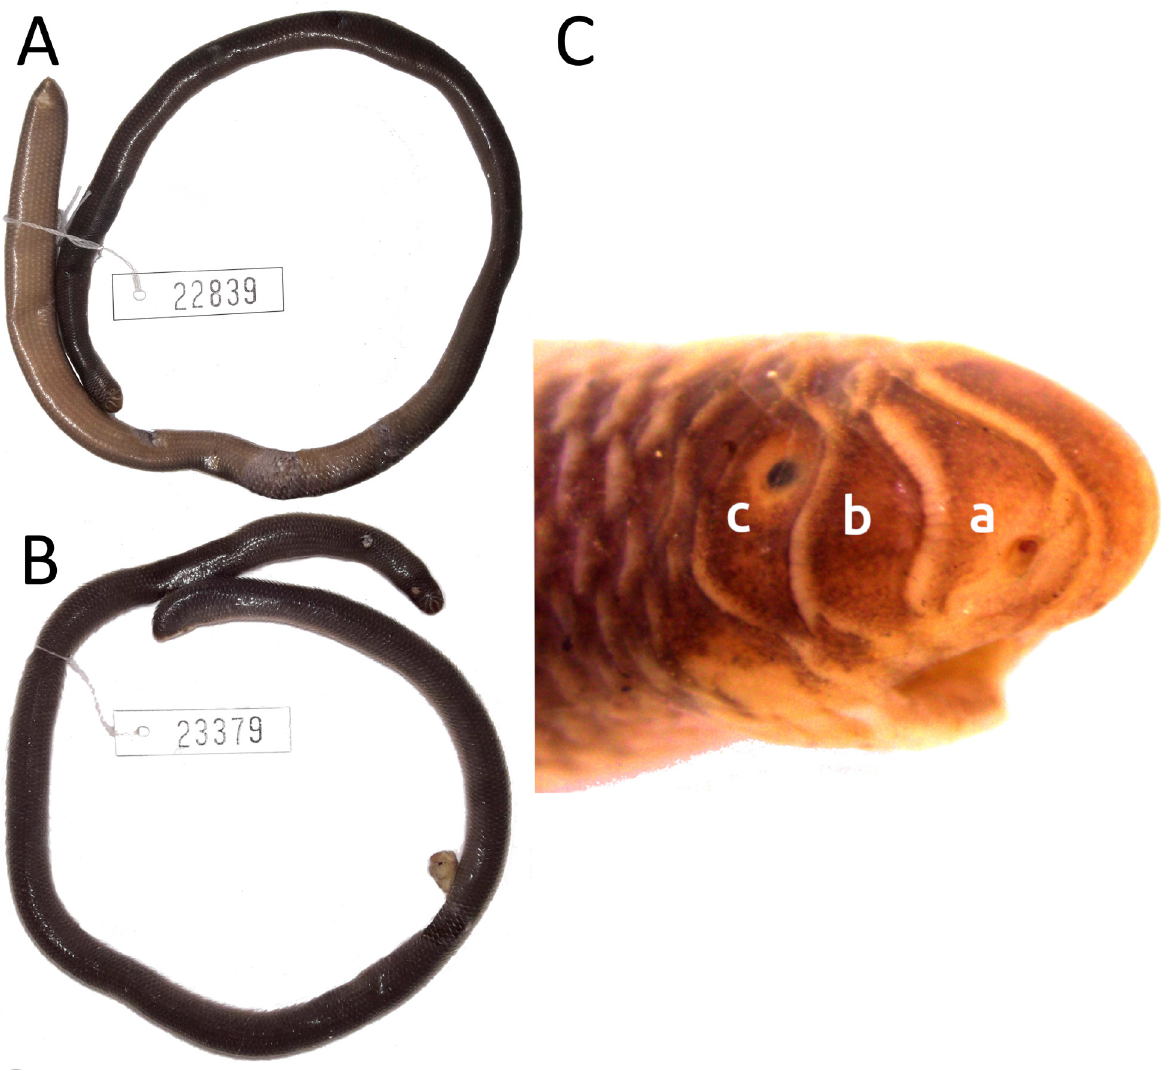
Figure 2. New specimens of Amerotyphlops costaricensis . A. Juvenile UCR 22839 from Cervantes, Cantón Alvarado, Cartago Province . B. Juvenile UCR 23379 from Cachí, Cantón Paraíso, Cartago Province. C . Diagnostic characters of A. costaricensis as exhibited by UCR 22839: a) Fusion of prefrontal with supranasal scale. b) Pre-ocular scale present. c) Subocular scale